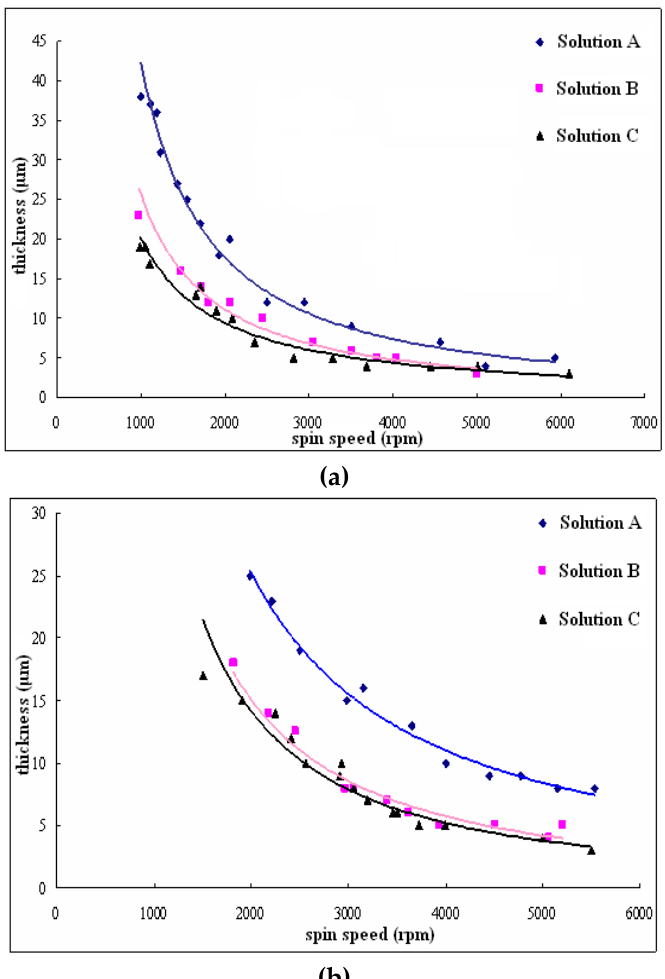
Figure 2. Relationships between the spin speed and film thickness for different cases. EVA solutions at three concentrations were considered to form the films on two surfaces: ( a ) inactivated glass board and ( b ) EVA-coated board. Because the friction force was stronger for the EVA-pretreated board, the corresponding film was thicker than for the inactivated glass board for the same spin speed.